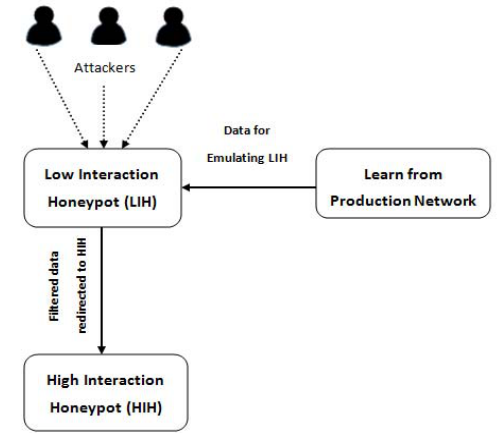
Fig. 1. Abstract structure of the proposed